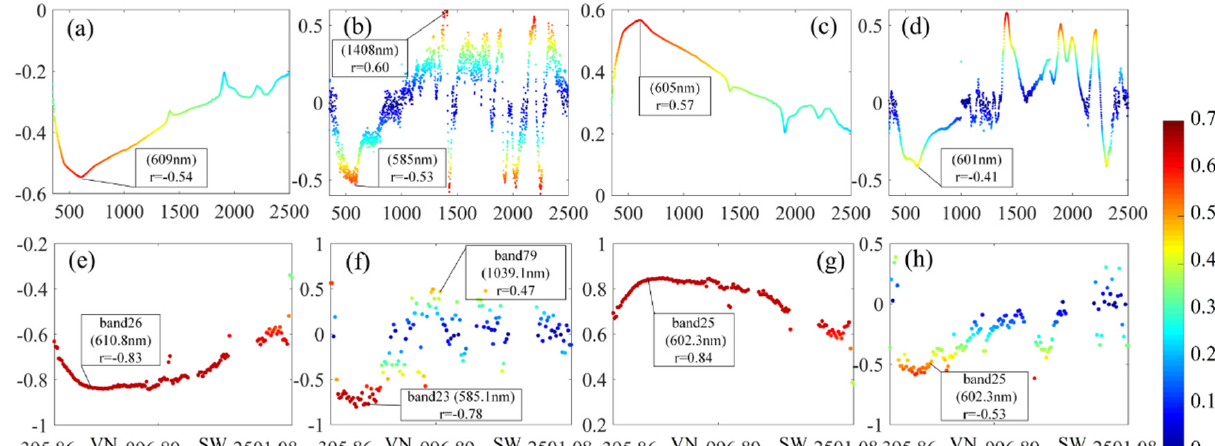
Figure 9. ( a – d ) show the Pearson correlation coefficient between the soil N content and 4 forms of lab spectra of Dt5 dataset; Correspondingly ( e – h ) show the Pearson correlation coefficient between the soil N content and 4 forms of spectra of ZY1-02D (AHSI) of De dataset. Axis X indicates the spectral region (unit: nm). Axis Y indicates the Pearson correlation coefficient. The color bar indicates the absolute value of the correlation